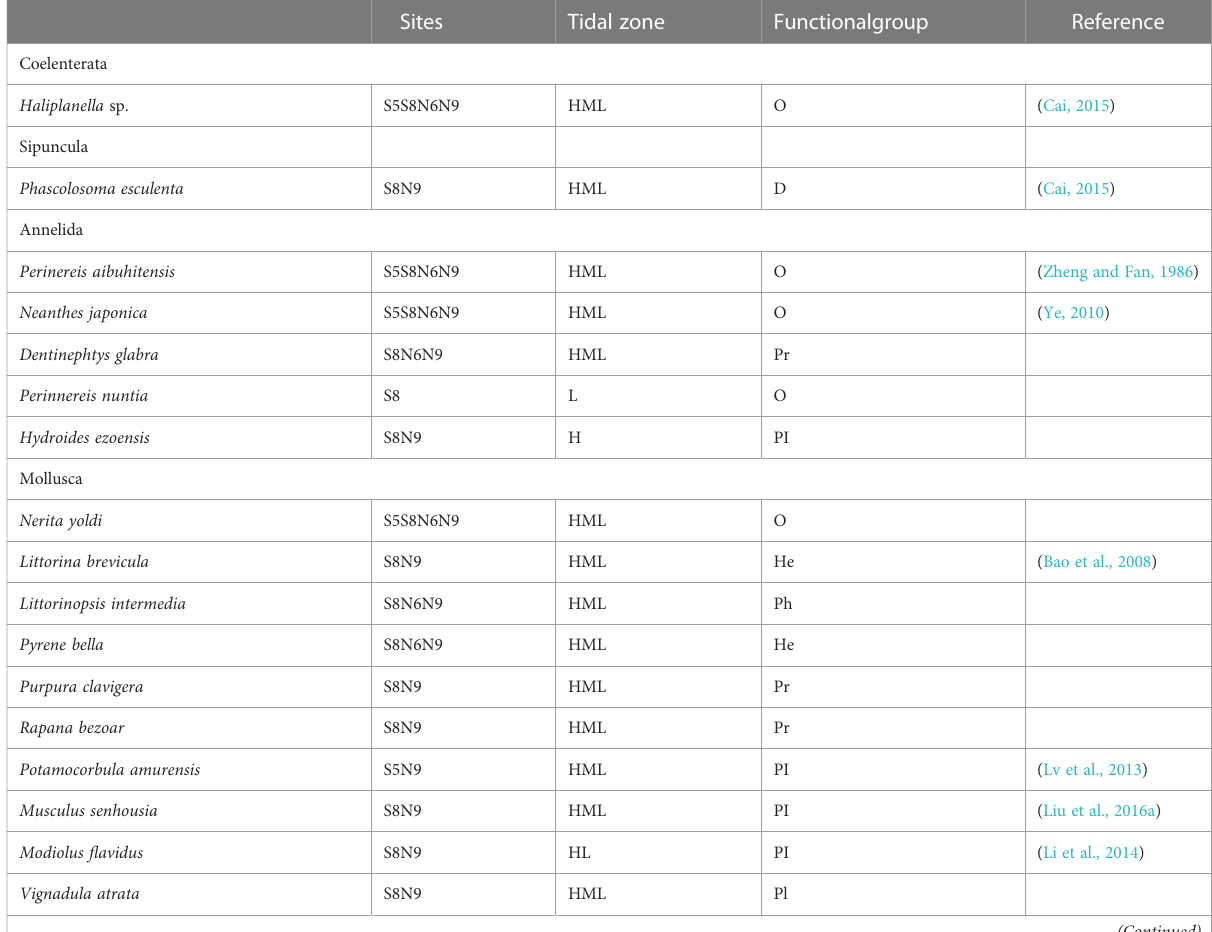
TABLE 1 Macrobenthos collected from the arti fi cial intertidal oyster reef. Sites Tidal zone Functionalgroup Reference Coelenterata Haliplanella